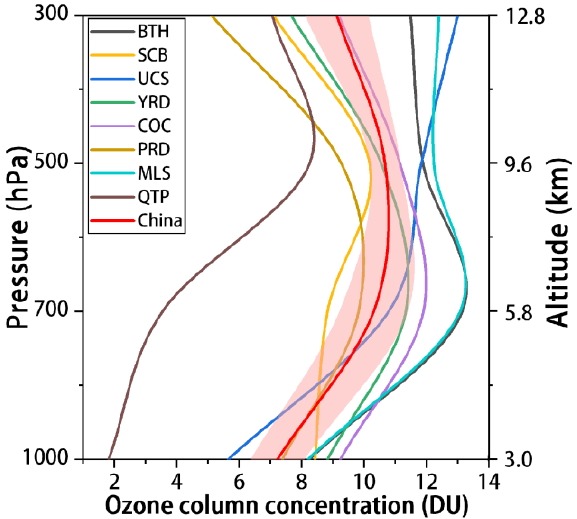
Figure 2. The average tropospheric ozone profile over the study